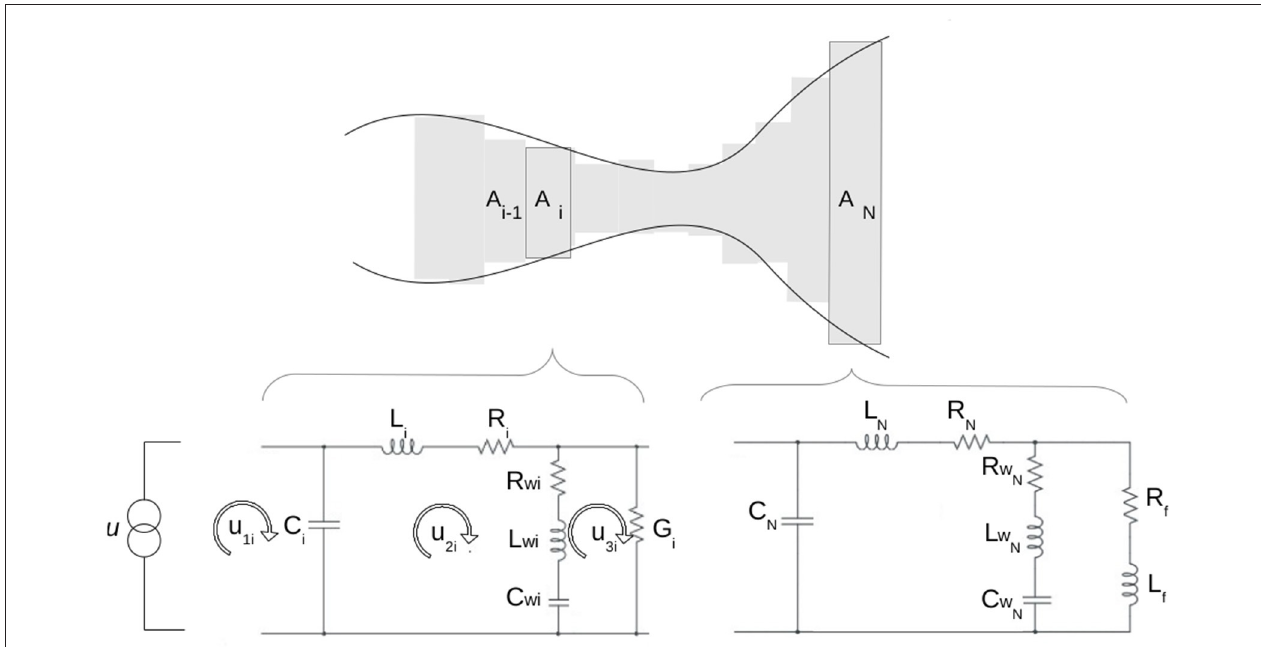
FIGURE 2 | Articulatory synthesizer. Sketch of the model used for the vocal system. The glottal airflow ( u ) is obtained by solving a Van del Pol system (Laje et al., 2001). The vocal tract is approximated by a concatenation of N = 44 tubes of different cross-sectional areas A i and lengths l i . The lower panels show the equivalent electrical transmission line used to simulate the propagation of the sound along the ith and the last tube ( N ),